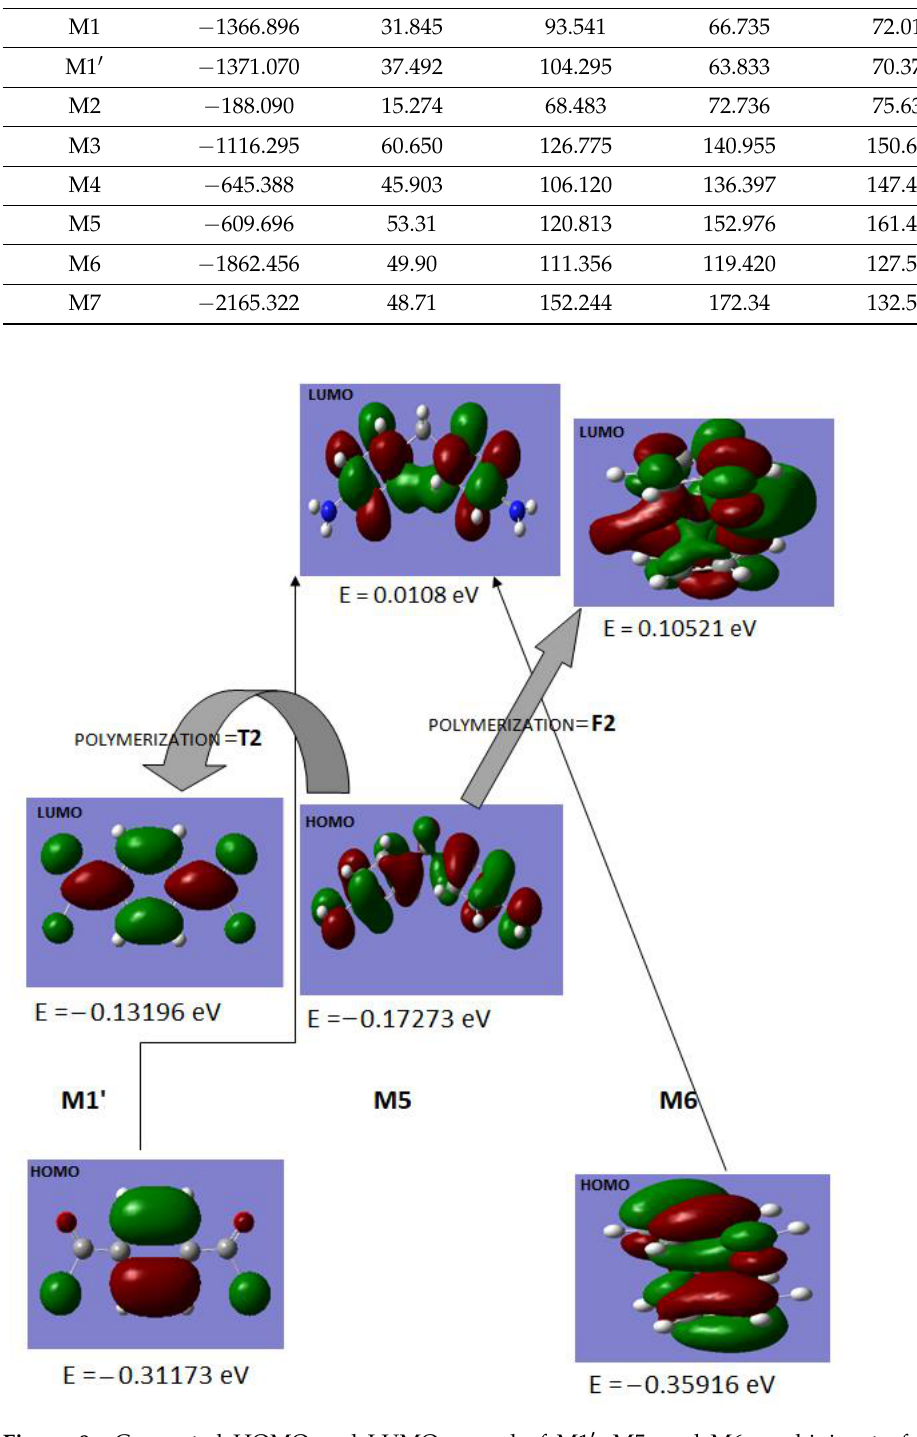
Figure 8. Computed HOMO and LUMO spread of M1′, M5, and M6 combining to form T2 (M1′ + M5) and F2 (M5 + M6) at DFT/B3LYP/6-311G** (d, p) basis set.